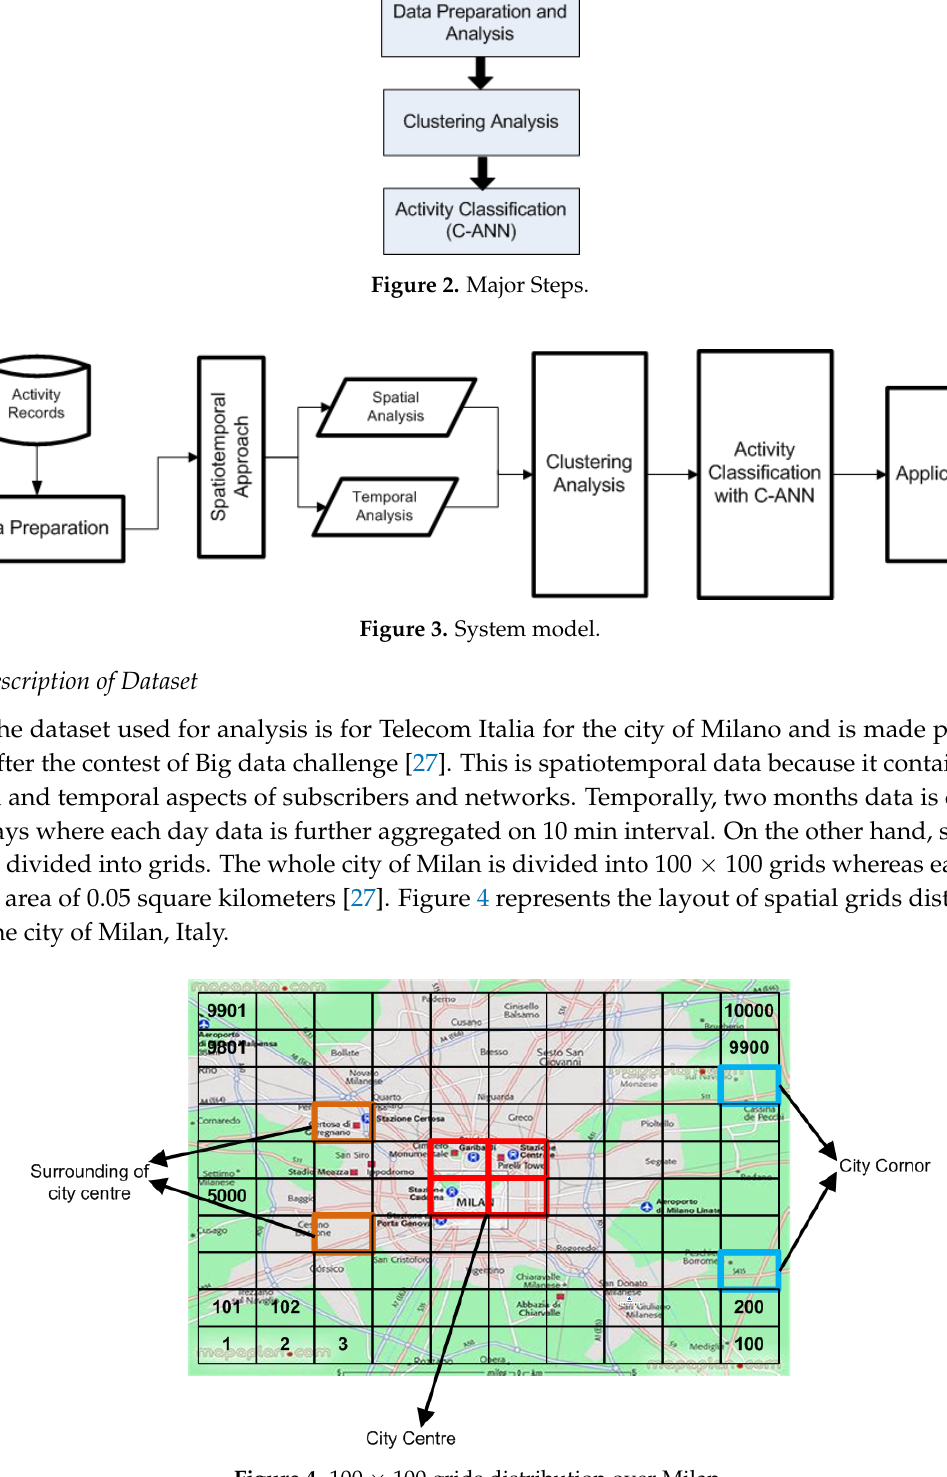
Figure 4. 100 × 100 grids distribution over